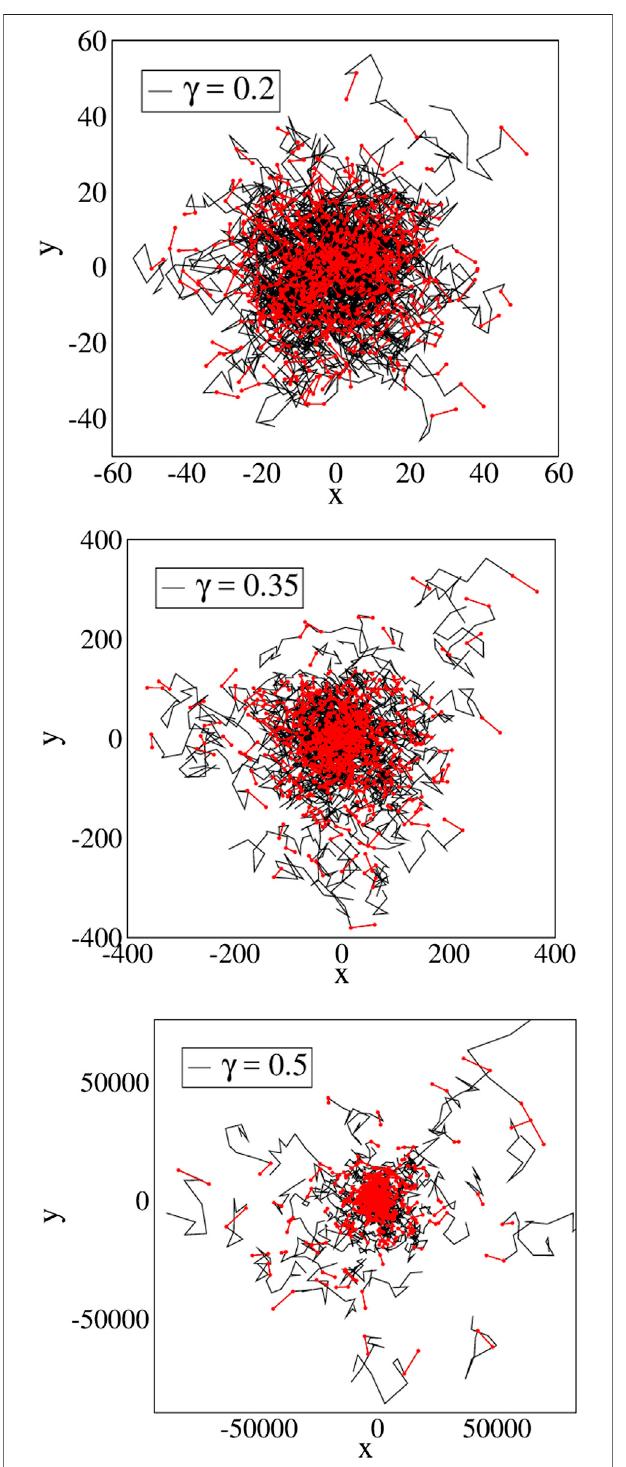
FIGURE 2 | The sphere of volume V r containing the N r (cid:1) 10 particles that de fi nes the local concentration for the central particle.